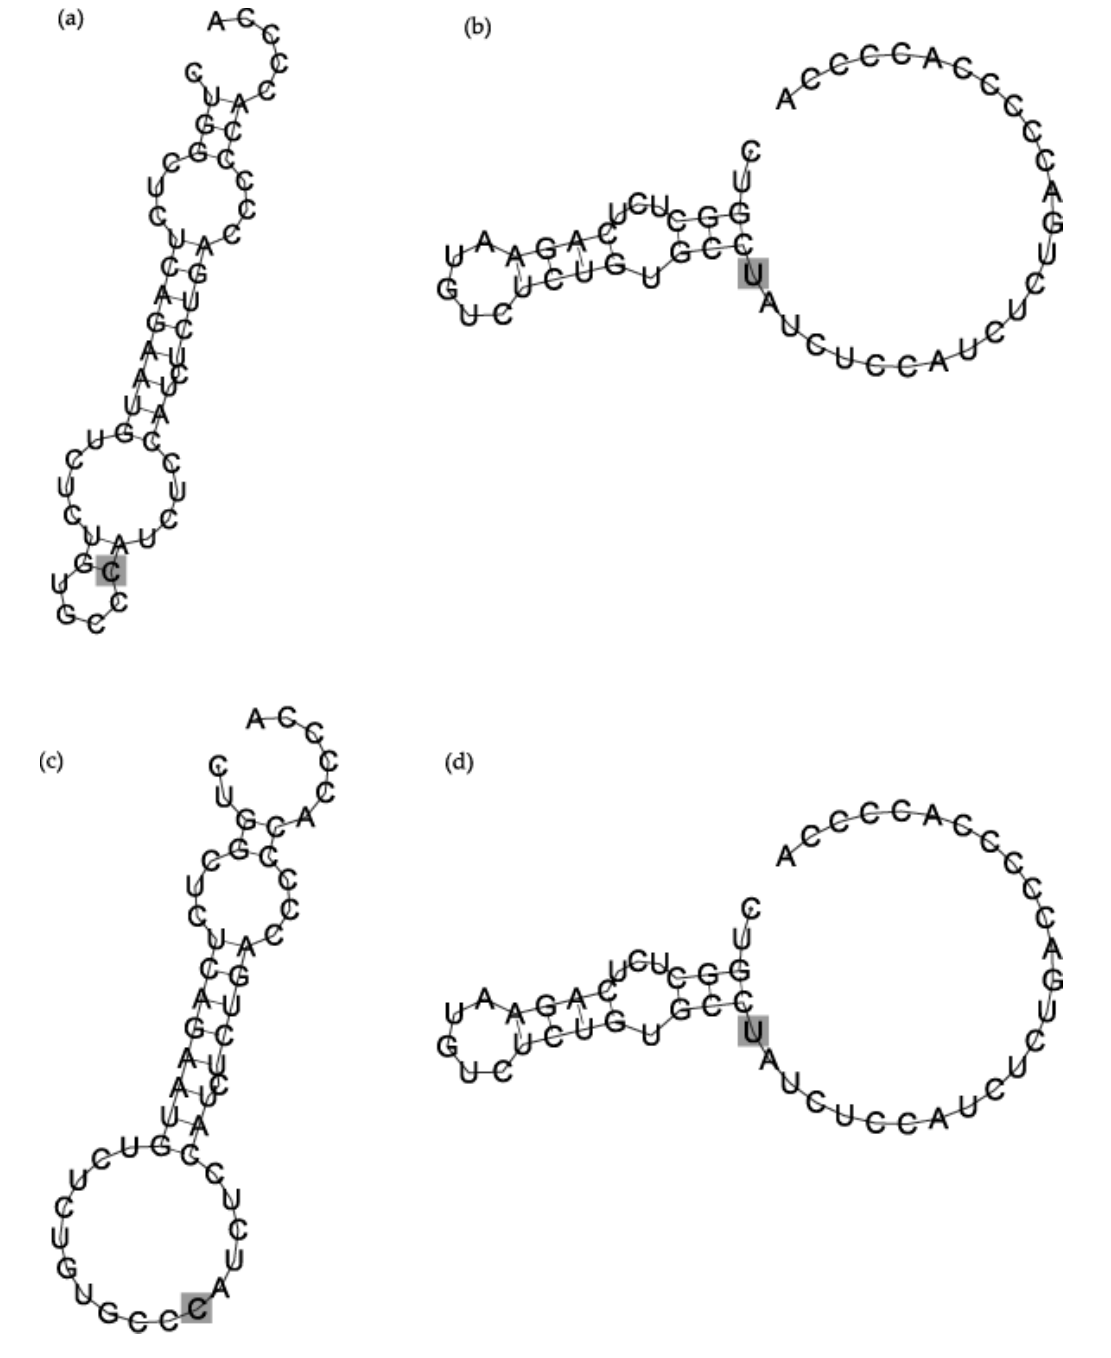
Figure 2. The 2D structures of 51-miR-125a with C-variant and U-variant predicted by RNAfold. In grey squares we marked SNPs. ( a ) C-variant MFE model (minimizing free energy), ( b ) U-variant MFE model (minimizing free energy) ( c ) C-variant variant centroid model (minimizing base-pair distance) and ( d ) U-variant centroid model (minimizing base-pair distance).